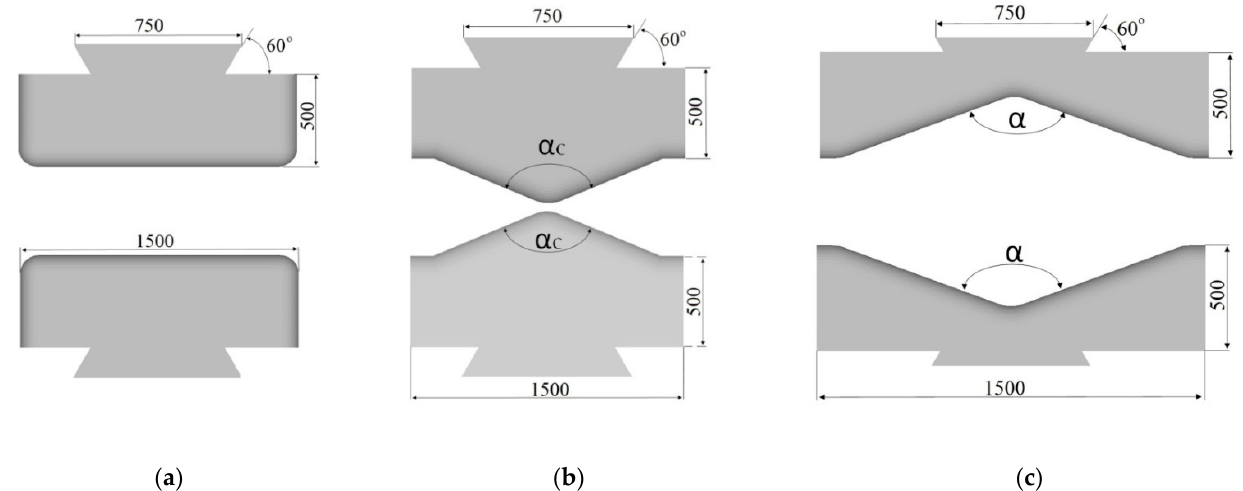
Figure 2. Shape of anvils: ( a ) flat, ( b ) convex (angle: α c = 135°, 150° and 165°), and ( c ) V-shaped ( α = 140°), the numbers in the figure in mm.